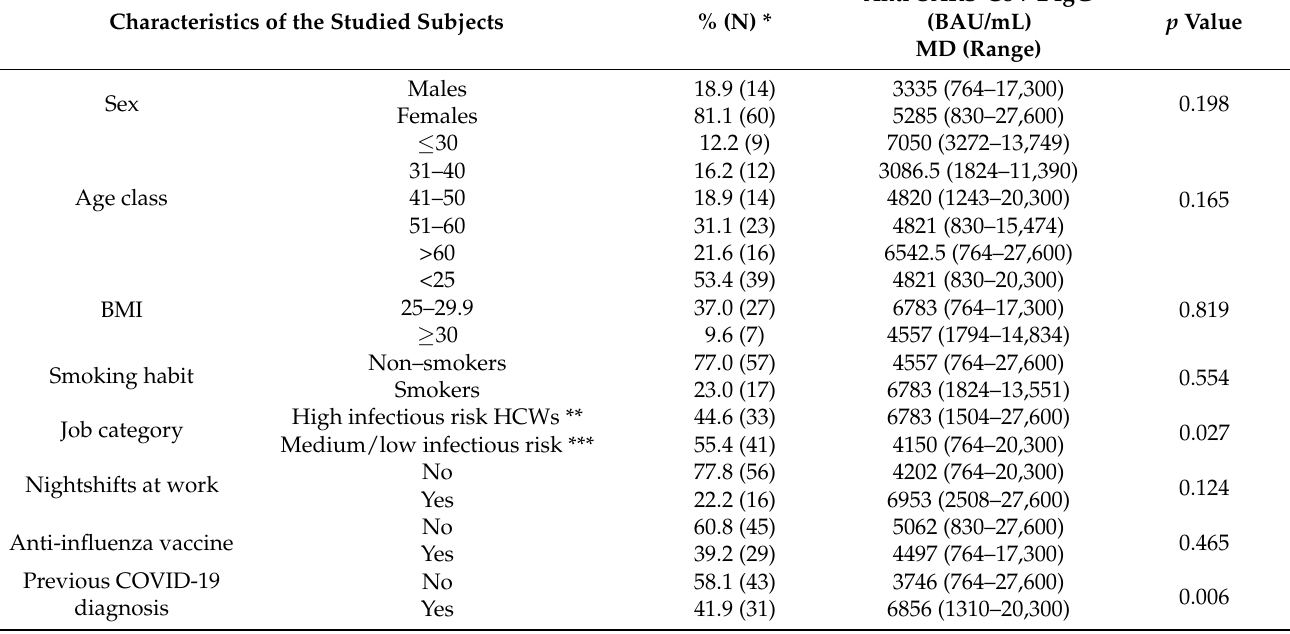
Table 1. Median values and range of neutralizing antibodies against SARS-CoV-2, measured 4 weeks after two doses of the BNT162b2 vaccine administered 4 weeks apart, in 74 workers of an Italian nursing home grouped according to the main individual and occupational